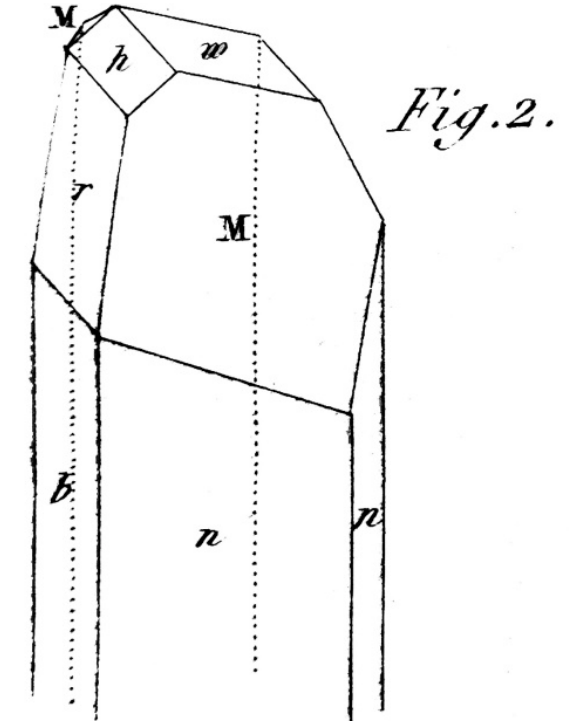
Figure 8. Hemihedral crystal of tartaric acid from the article of H. de la Provostaye (reference 36, pl. 1, fig. 2) that inspired the research of L. Pasteur on the optical activity (reference